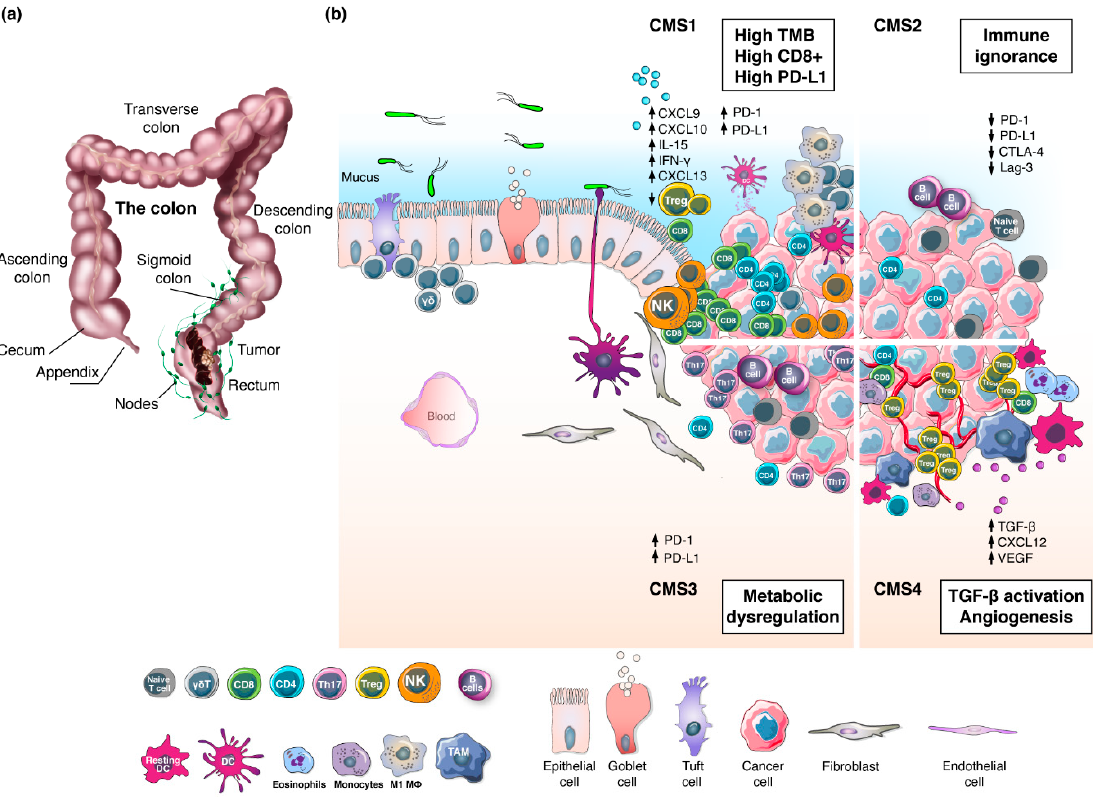
Figure 1. The rectal tumor microenvironment. ( a ) Illustration representing the anatomy of the large intestine and the development of a tumor localized in the rectum. ( b ) The four consensus molecular subtypes and their specific stroma-immune microenvironments. CMS1 cluster displays strong immune activation with high levels of CD8 + T cells, CD4 + T cells, γδ T cells, activated dendritic cells (DCs), natural killer (NK) cells and M1 macrophages alongside high expression of cytokines, PD1, PD-L1 and MHC-I. CMS2 shows an immune-desert microenvironment characterized by a few immune cells and poor expression of PD1, PD-L1, LAG-3 and CTLA-4. CMS3 is distinguished by metabolic dysregulation, infiltration of Th17 cells, naive B and T cells, and expression of MHC-I, PD1 and PD-L1. CMS4 exhibits high angiogenesis activity, expression of TGF- β , and infiltration of CD8 + T cells, CD4 + T cells, Tregs, M2 macrophages, monocytes, eosinophils and resting DCs.